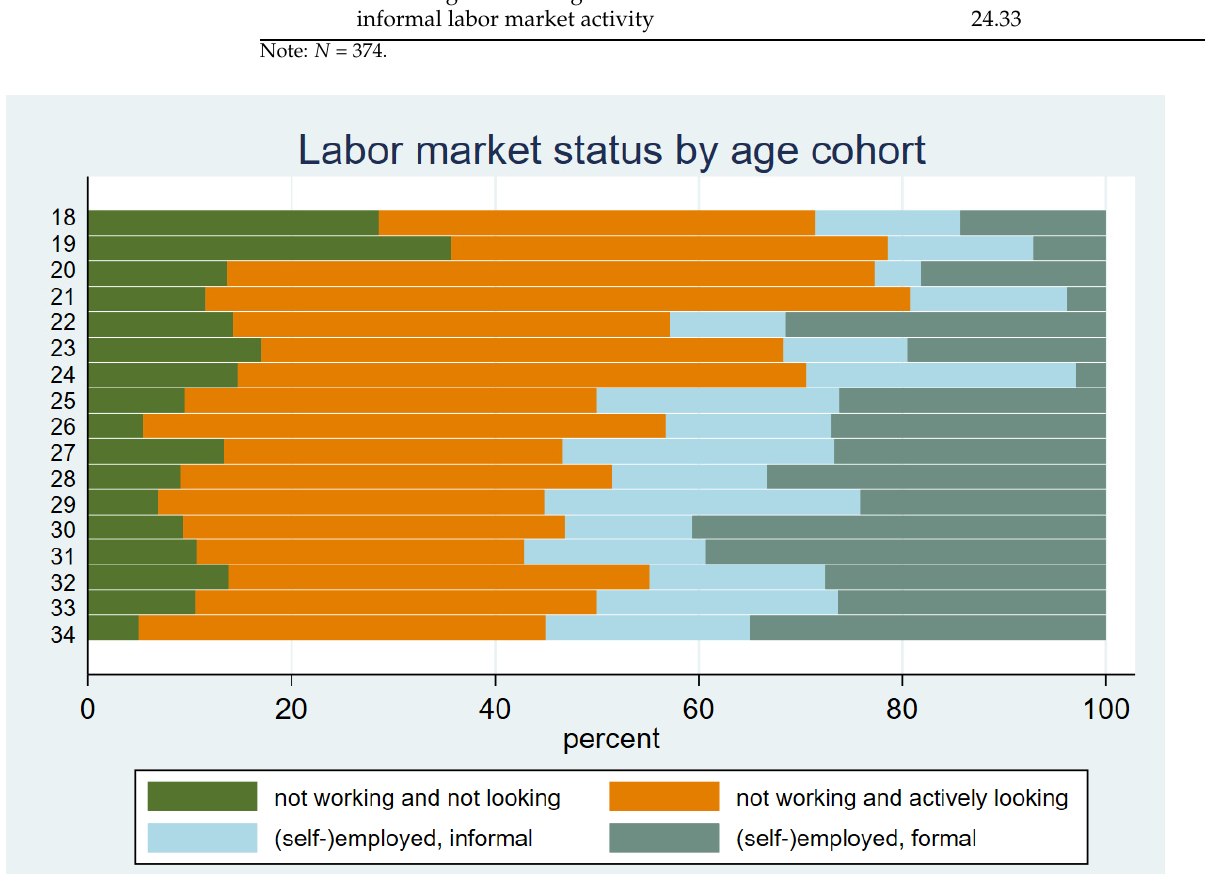
Figure 2. Labor market status by age cohort.